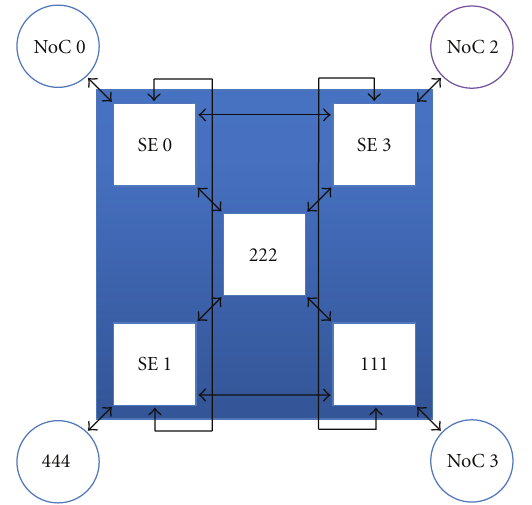
Figure 12: The simulation state of NiP-PNN model at fifth step of best case.